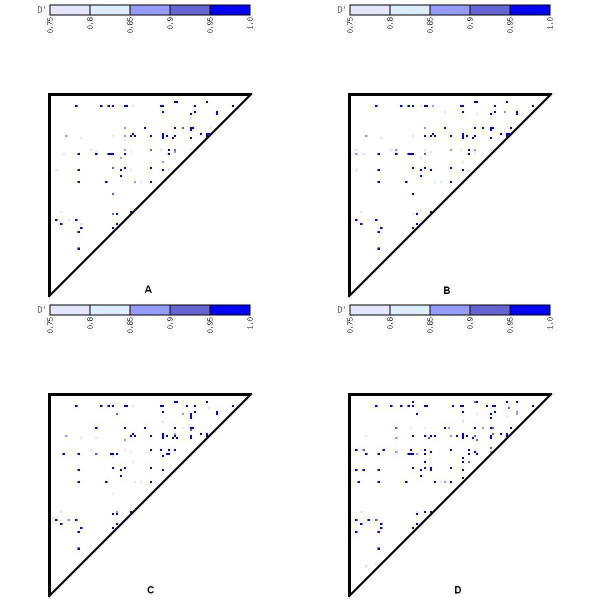
Plots of the LD coefficient D' for region 2 in the Aipotu population. A, Full dataset with no missing values; B, 1% missing genotypic data; C, 5% missing genotypic data; D, 10% missing genotypic data.